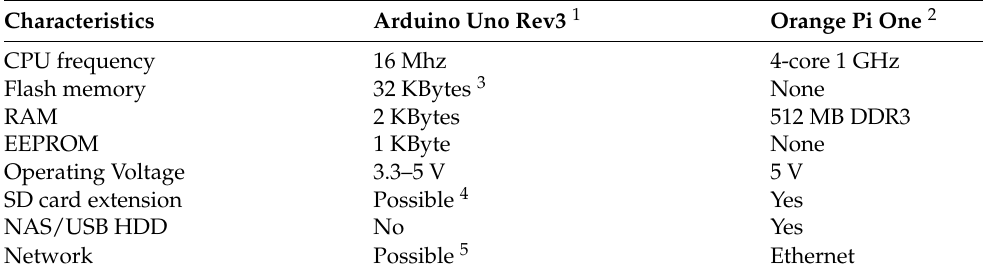
Table 1. Comparison of popular MCU (left) and SoC (right). Characteristics